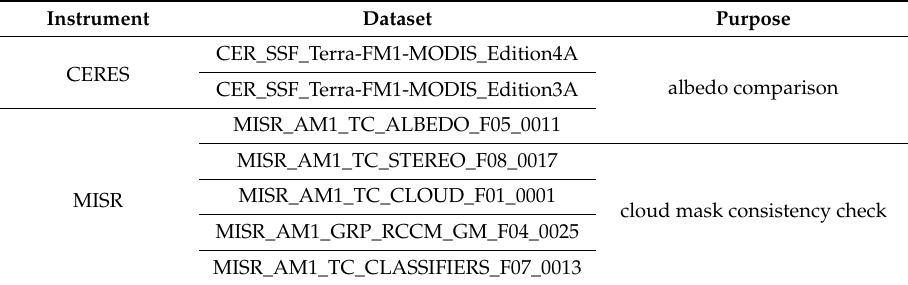
Table 1. Datasets used in this